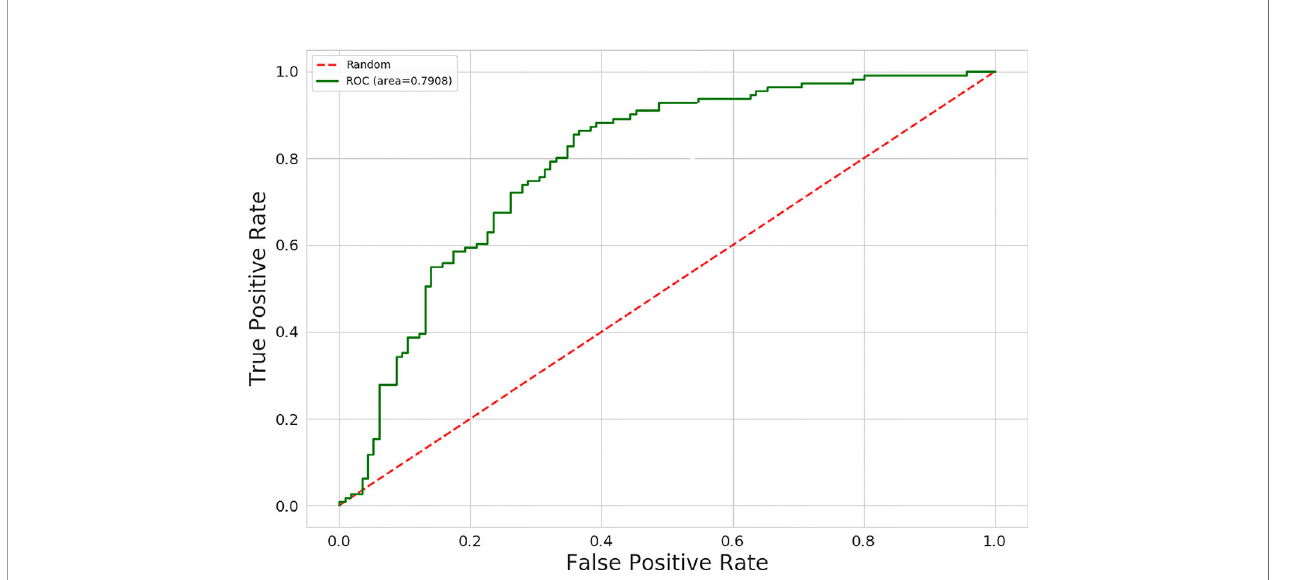
FIGURE 3 | The ROC curves of the radiomics signature in the training